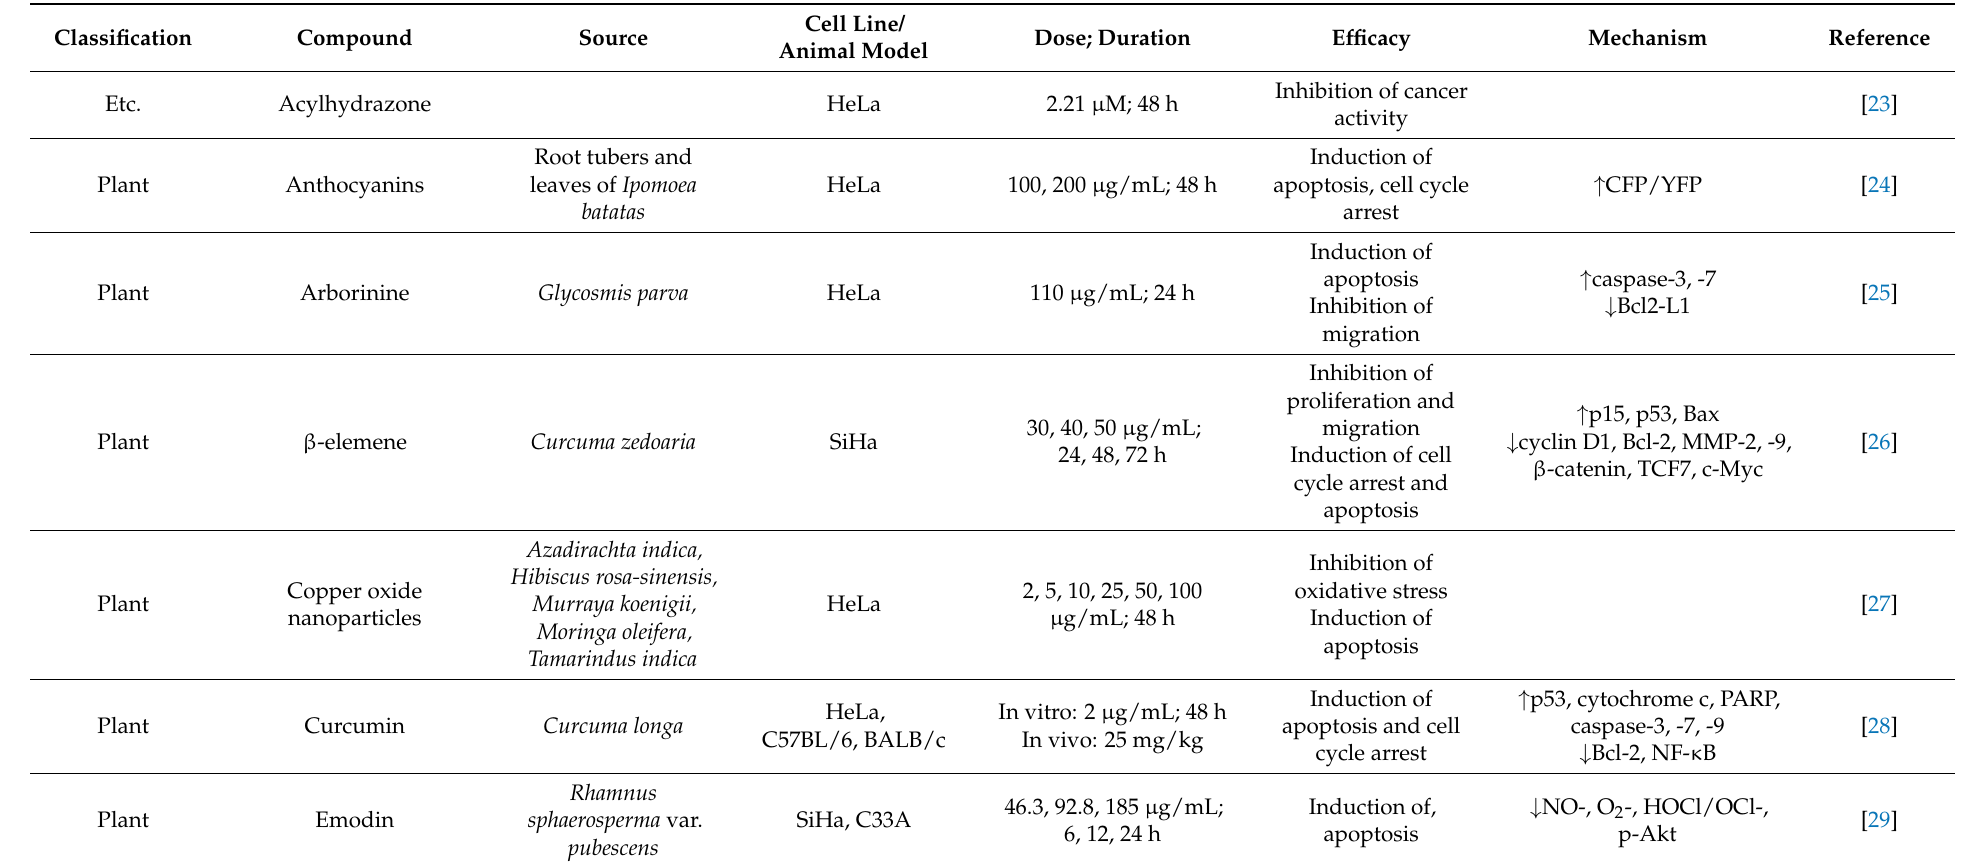
Table 1. Apoptosis inducing natural